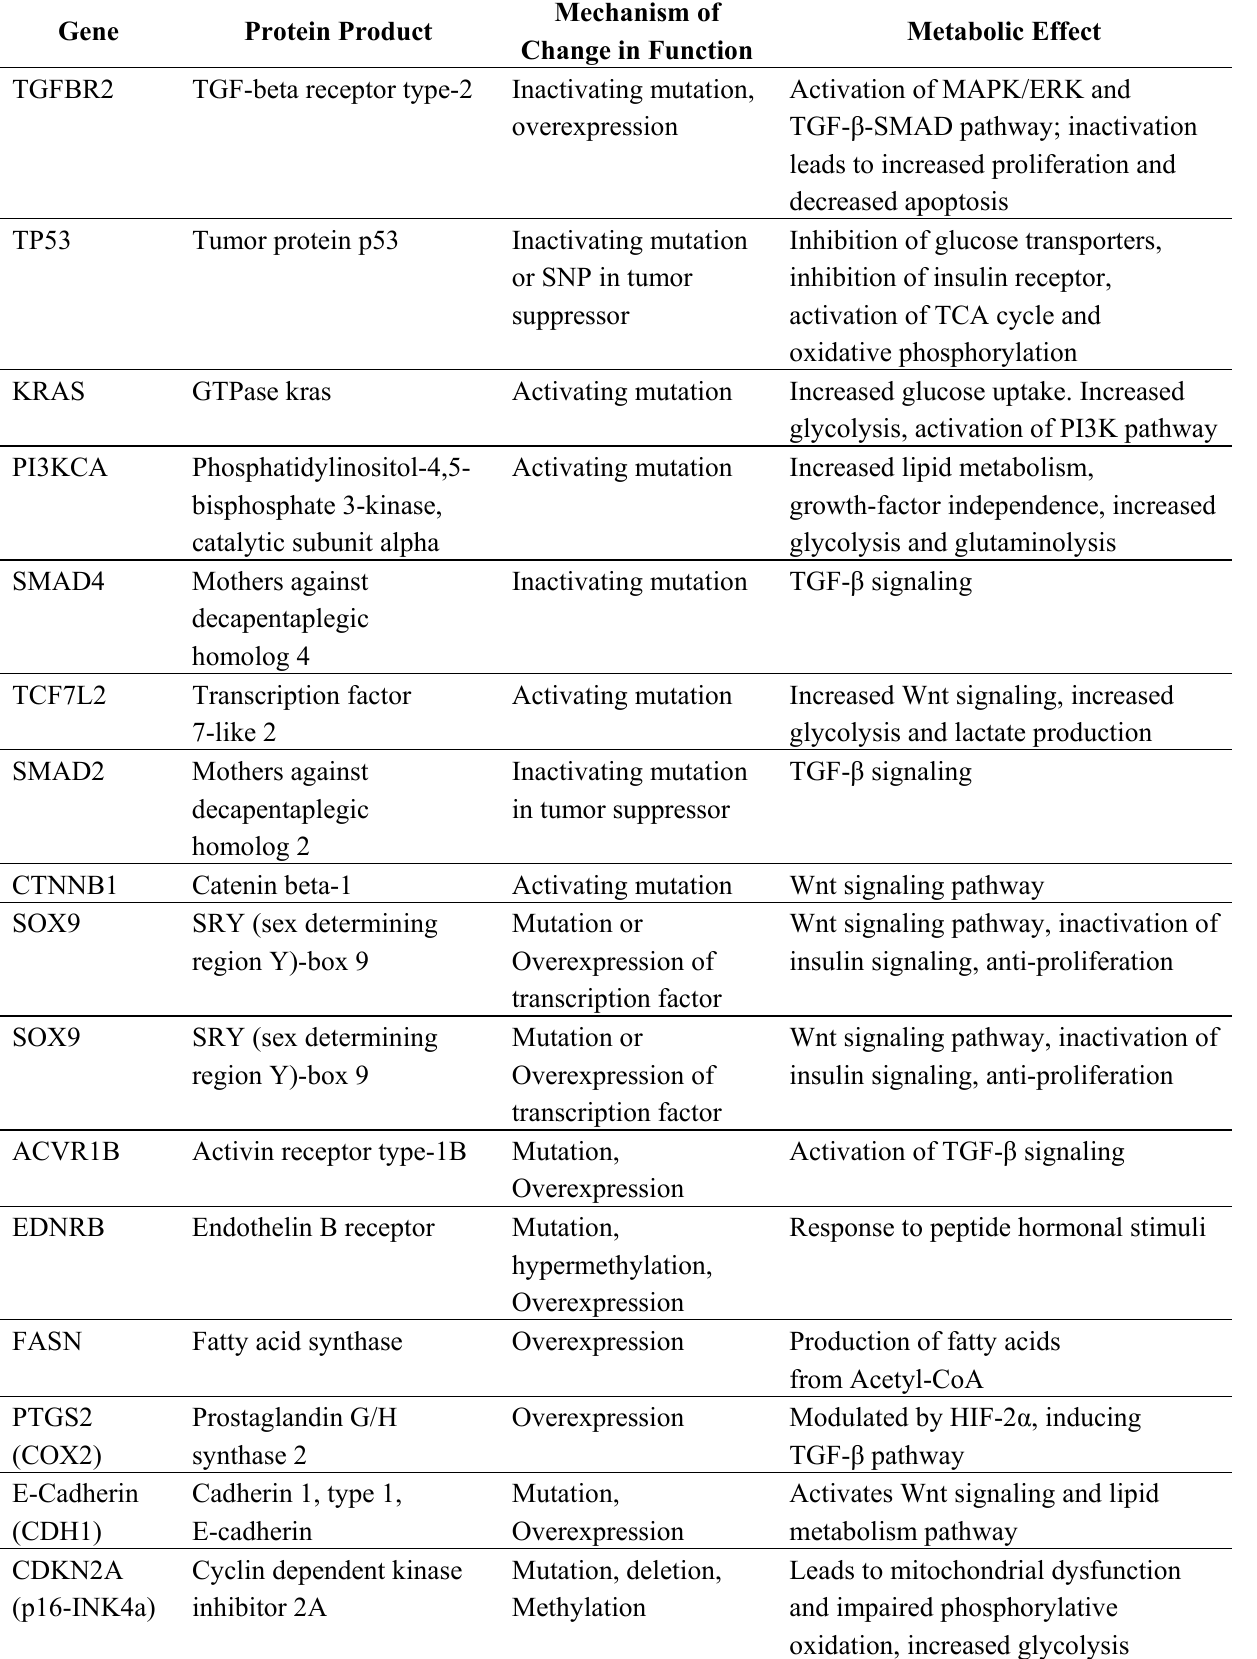
Table 1. Examples of genetic and epigenetic alterations in colorectal cancer (CRC) that have known or potential metabolic